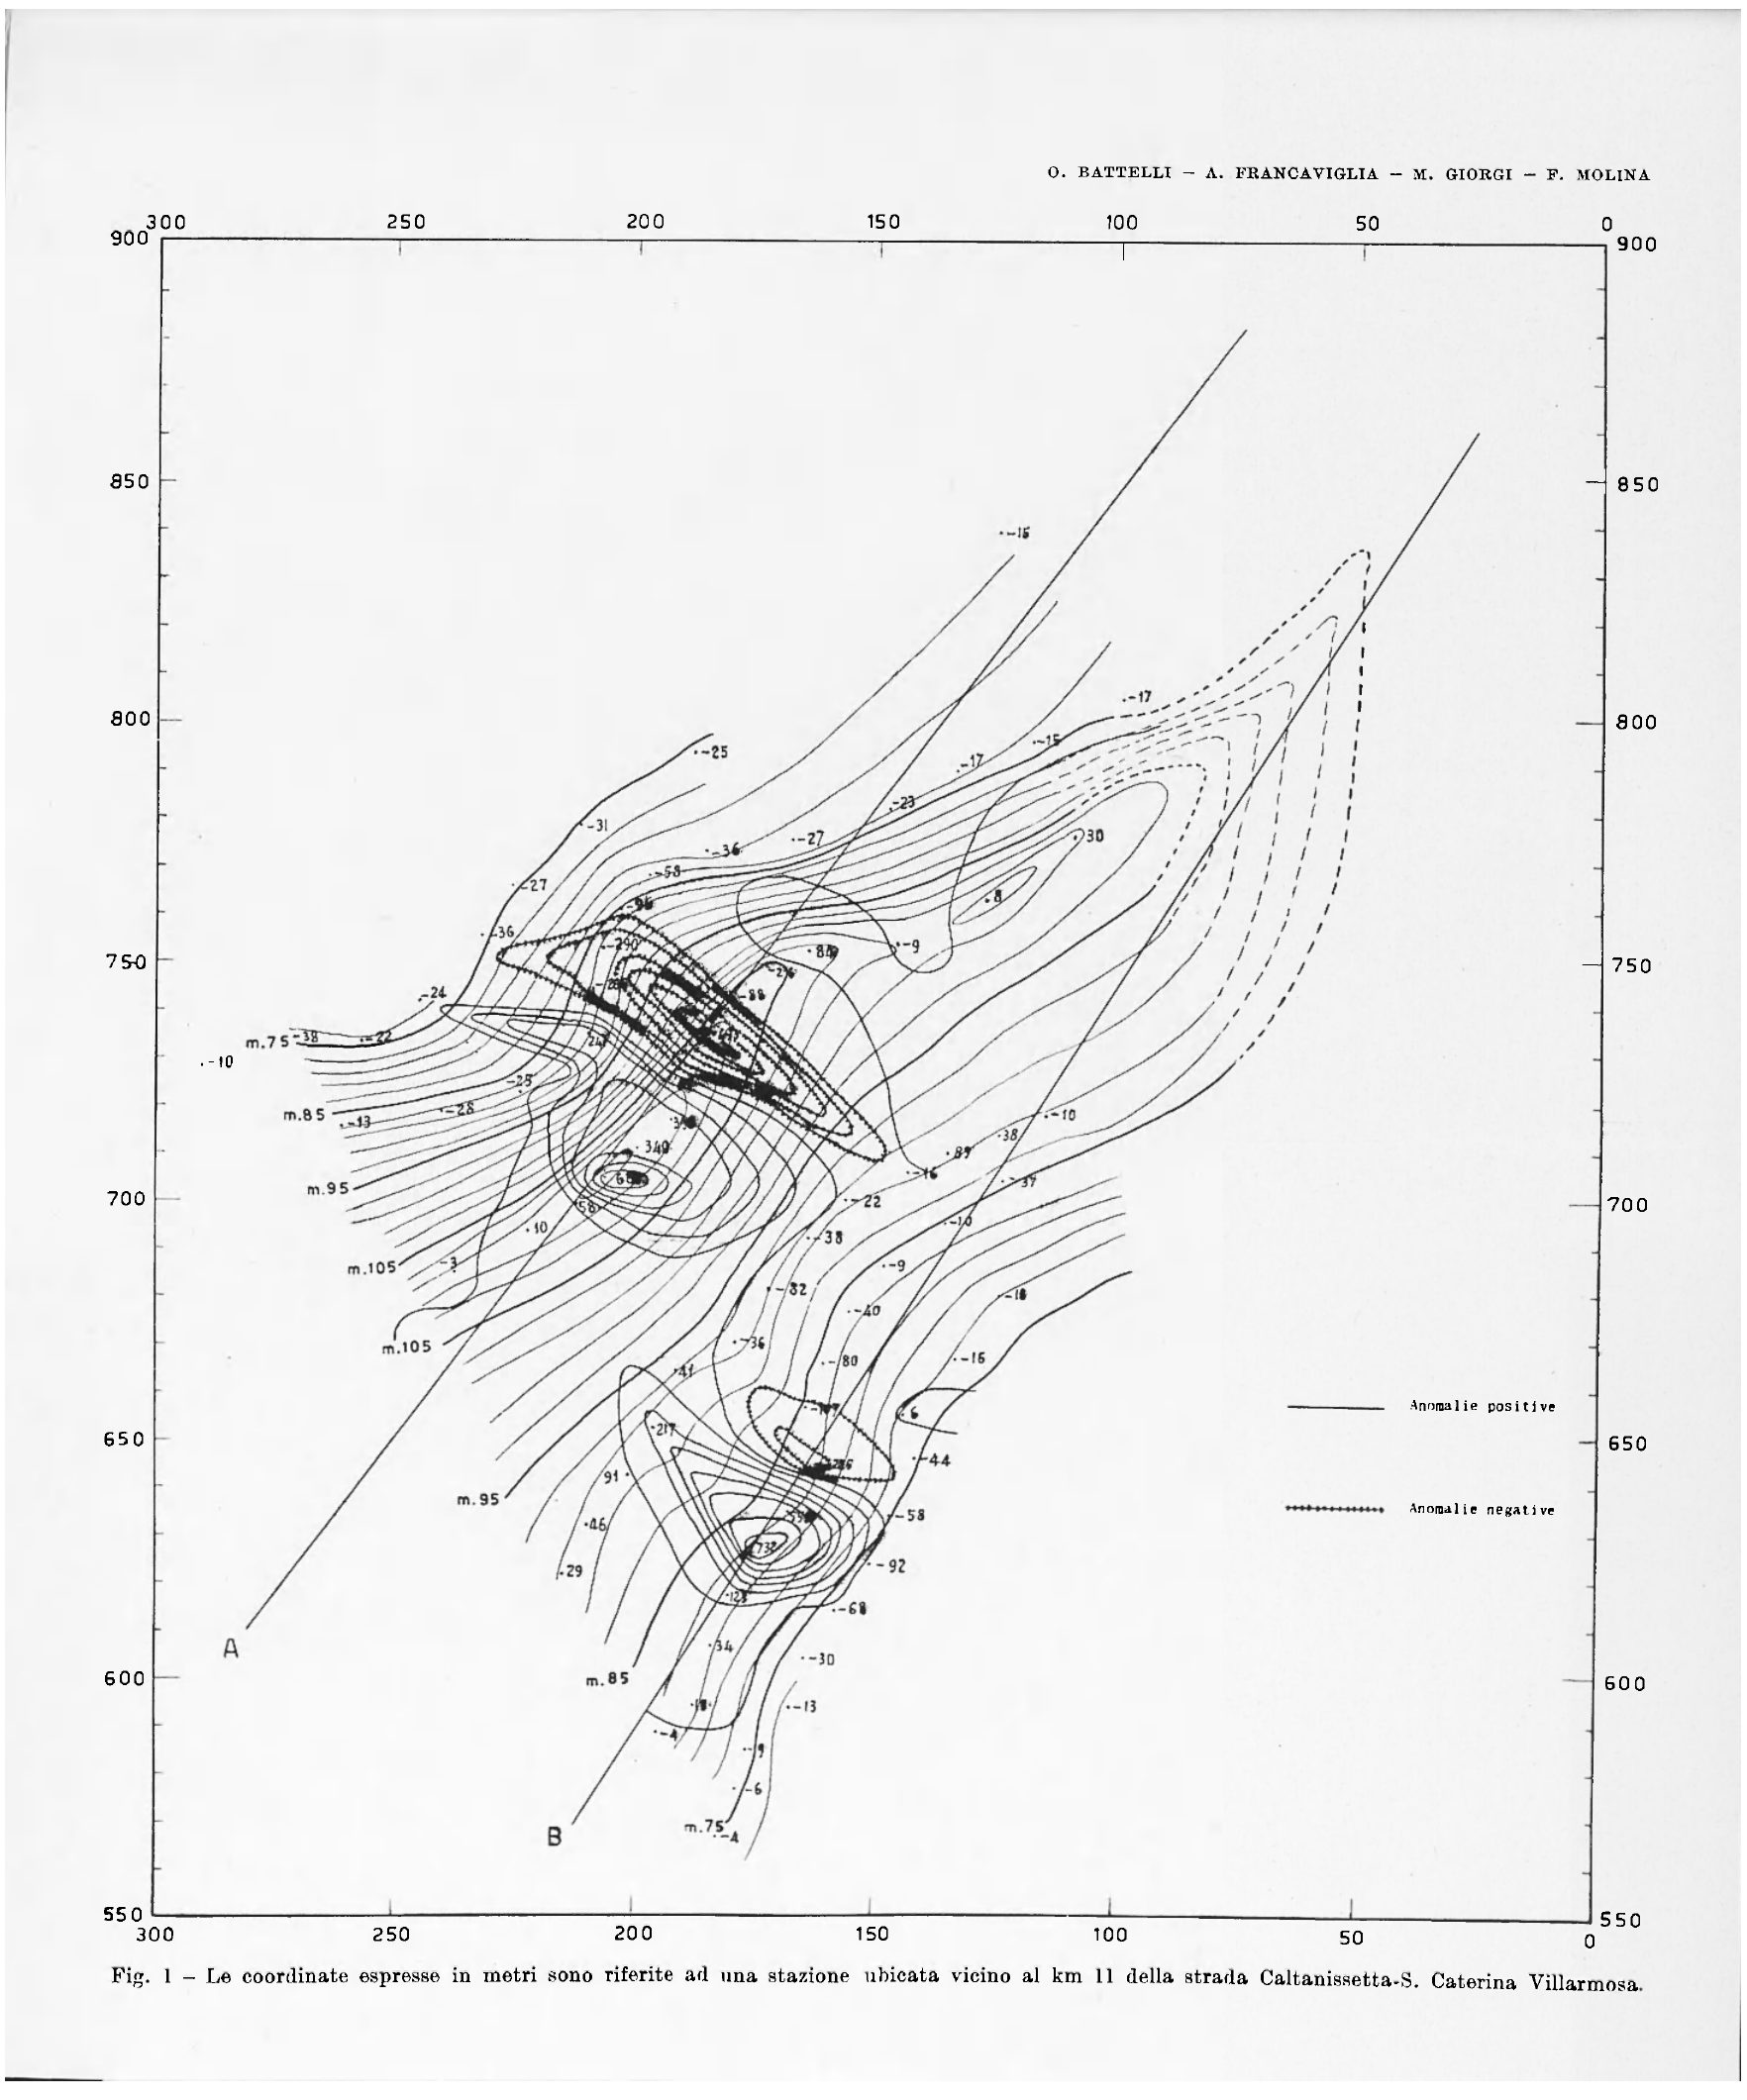
Fig. 1 - Le coordinate espresse in metri sono riferite ad una stazione ubicata vicino al km 11 della strada Caltanissetta-S. Caterina